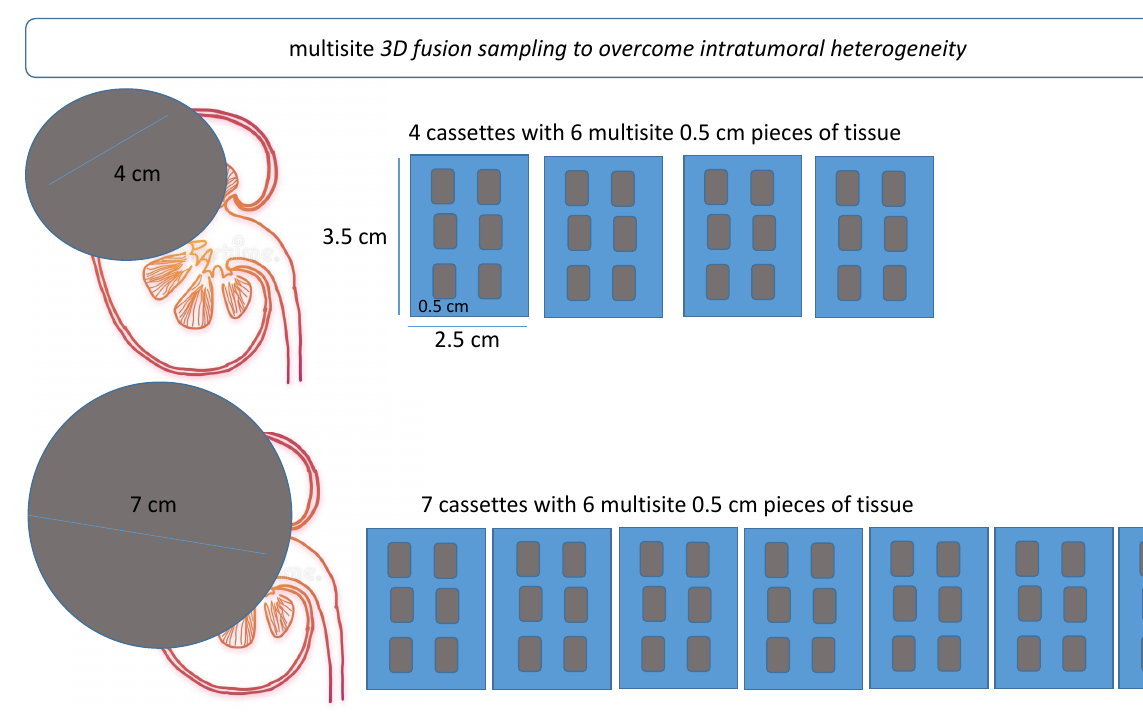
Figure 2. Schematic representation of multisite 3D fusion sampling procedure. Fusion sampling was based on the size of the tumor. For each cm diameter of tumor, six blocks of tissue, each measuring 0.5 × 0.5 cm, were randomly selected and placed in an individual cassette.